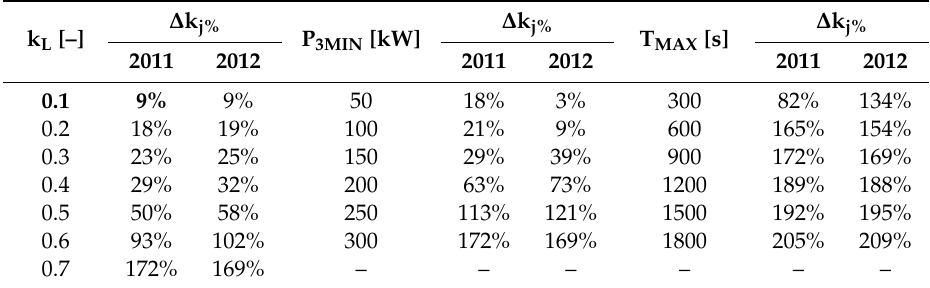
Table 2. Increase inthe unit cost of electricity generation ∆ k j% for an optimised wind power plant–energy storage system (WPP-FESS system with the power rating of 2 MW compared to an optimised system without energy storage for different values of k L , P 3MIN and T MAX .